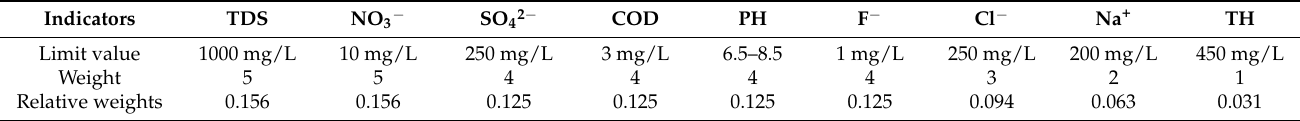
Table 3. List of parameters, weight factors and limits of water quality